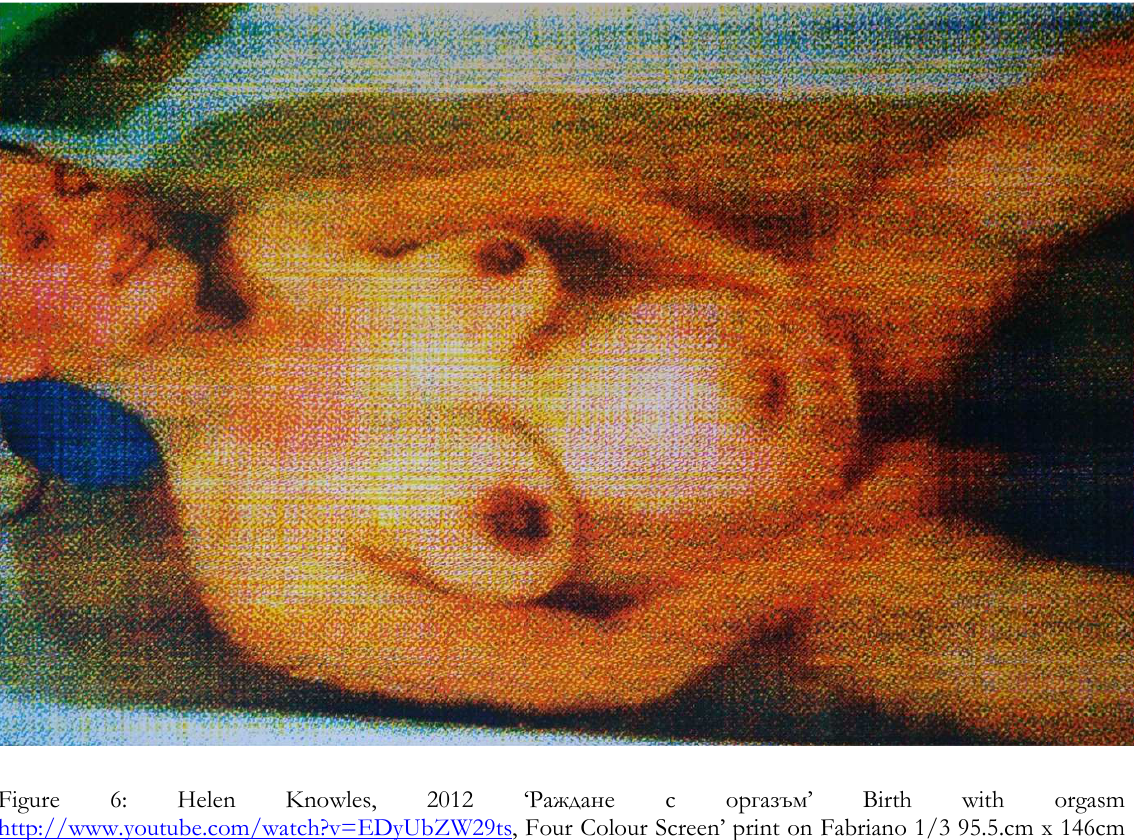
Figure 6: Helen Knowles, 2012 ‘Раждане с оргазъм’ Birth with orgasm http://www.youtube.com/watch?v=EDyUbZW29ts, Four Colour Screen’ print on Fabriano 1/3 95.5.cm x 146cm 2012 Edition of 3. Reproduced with the permission of the